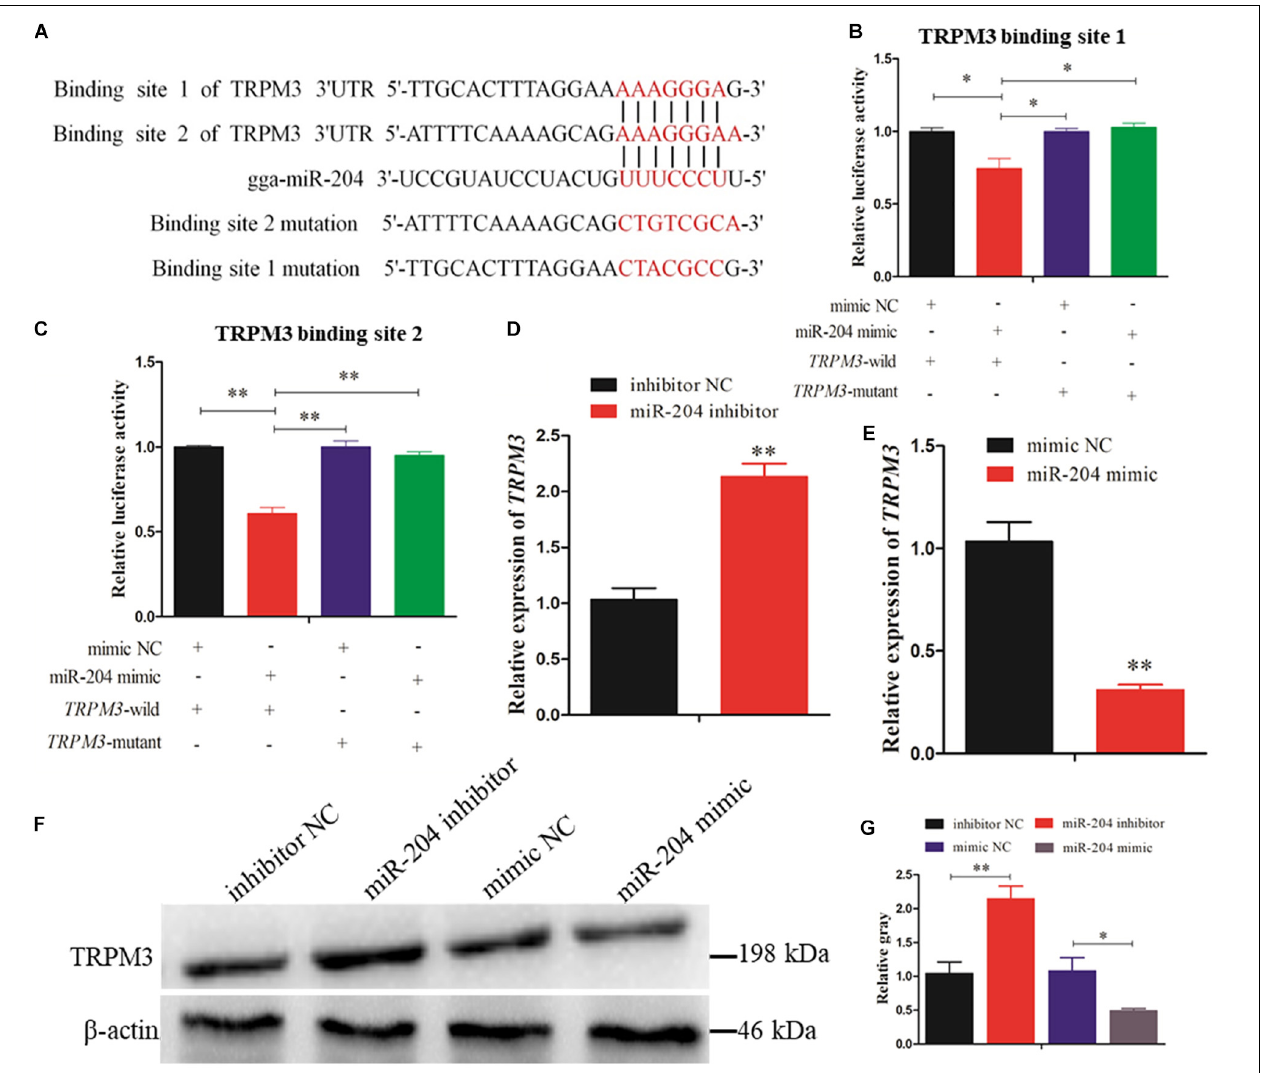
FIGURE 7 | Dual-luciferase reporter gene assays confirmed that miR-204 directly interacts with these two binding sites of transient receptor potential melastatin 3 (TRPM3). (A) The target positions of miR-204 seed sequence on TRPM3 and wild or mutant sequence of TRPM3-3 (cid:48) -untranslated region (UTR). (B, C) Chicken DF-1 cells were co-transfected with TRPM3-3 (cid:48) -UTR wild or mutant dual-luciferase vector and the miR-204 mimic or mimic negative control (NC). The relative luciferase activity was assayed 48 h later. (D, E) The mRNA expression of TRPM3 was detected after overexpression or inhibition of miR-204. (F, G) The protein levels of TRPM3 in chicken granulosa cells (GCs) were detected after transfection of overexpression or inhibition of miR-204. β -actin was used as a reference gene. Replications = 3. Data are presented as mean ± SE; * P < 0.05 and ** P <